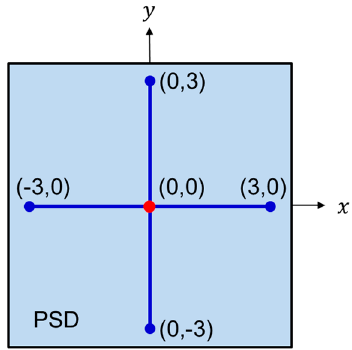
Figure 16. Schematic diagram of the test path design.